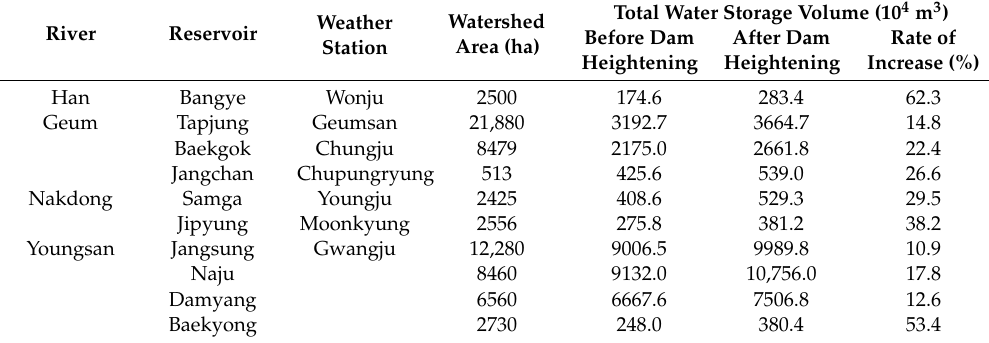
Table 2. Characteristics of selected reservoirs.